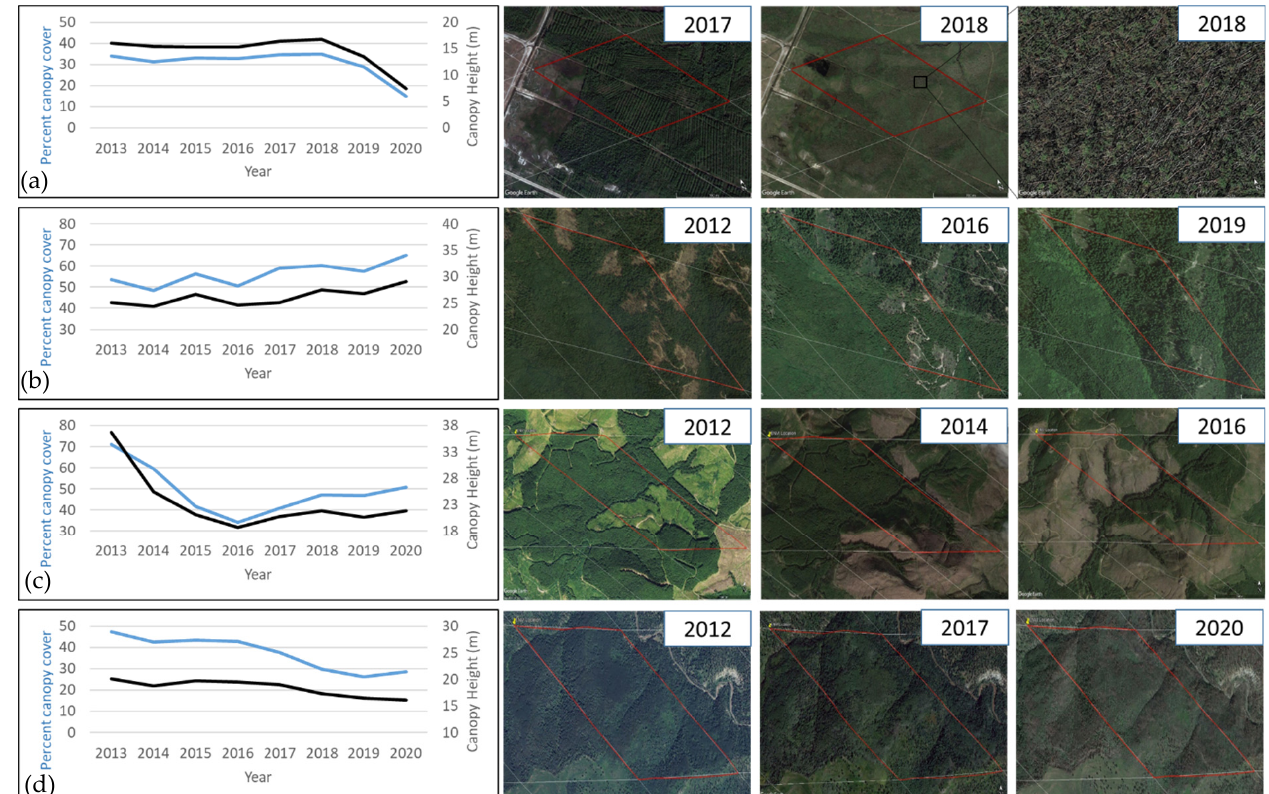
Figure 13. Annual canopy height (CH) and canopy fraction cover (CFC) derived from the annual VIIRS multi-temporal metrics observations acquired over 8 years (2013–2020) plotted over time for: ( a ) forest trees overthrown by wind damage from Hurricane Michael in the Florida panhandle; ( b ) gradual increases in forest height and canopy cover associated with natural growth in northern California; ( c ) a forest gradually thinned over multiple years (2013–2015) and recovered afterward in Washington State; and ( d ) subtle reductions in tree height and forest cover associated with environmental stress. Red polygons drawn on top of the GoogleEarth images show the 926-m VIIRS pixel area used to create the plots to the left.